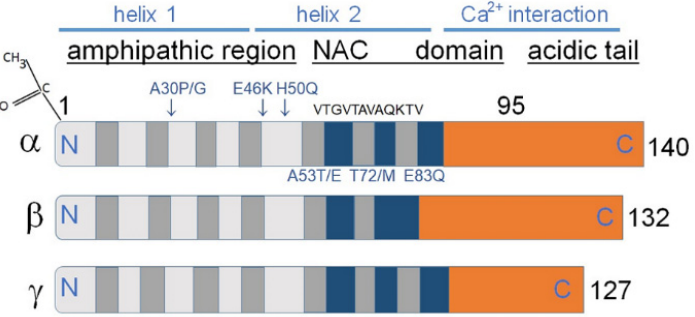
Figure 1. The core sections of the seven amino-terminal repeats (KTKEGV motive) are shown as dark grey bars in α and γ -synucleins. These motives are located between amino acids 7–87 of human α - and γ -synuclein. β -Synuclein has only six such repeats. Positively charged regions are shown in light gray, hydrophobic regions are blue, and negatively charged regions are light brown. In α -synuclein the non-amyloid- β component (NAC) is shown, containing amino acids 61–95, playing a key role in aggregation in vitro. The absence of this region in β -synuclein decreases its tendency to aggregate. Amino acids 71VTGVTAVAQKTV82 are the most essential for α -synuclein aggregation [8,9]; it is. This domain is partly absent in β -synuclein and to some extent conserved in γ -synucleins, which might clarify why both homologs of α -synuclein are not aggregation prone as α -synuclein. Some missense mutations predisposing to diseases (A 53 E, A 53 T, A 30 P, E 46 K, H 50 Q, T 72 M, and E 83 Q) are displayed as blue letters above and under the α -synuclein image (Modified from [10]). At the upper left corner N-terminal acetylation of α -synuclein is shown, which slows down its aggregation and changes the morphology of the aggregates [11,12].